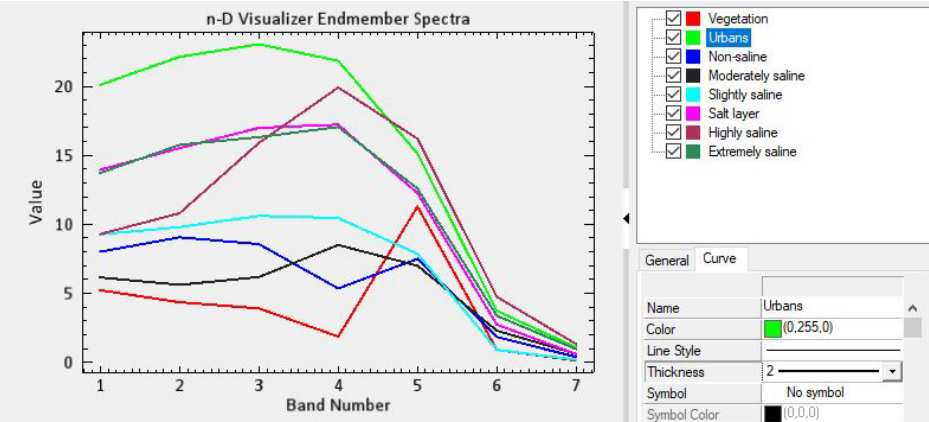
Figure 4. Field-derived salt-affected soils average spectra.